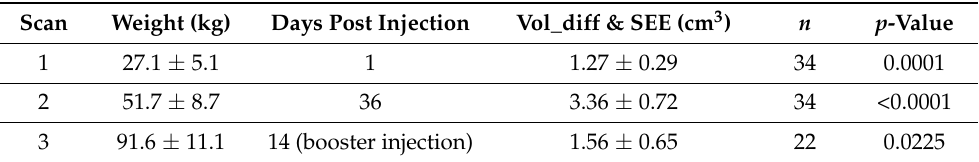
Table 2. Results of the paired t -Test ( p -value) divided into the different scans (1, 2, 3), including number of animals ( n ) at each scan. 5 MR images were evaluated and included in the Vol_diff calculation. Scan Weight (kg)